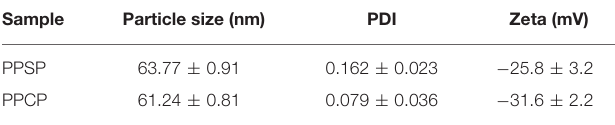
TABLE 1 | Reproducibility study of the micellar prescription.